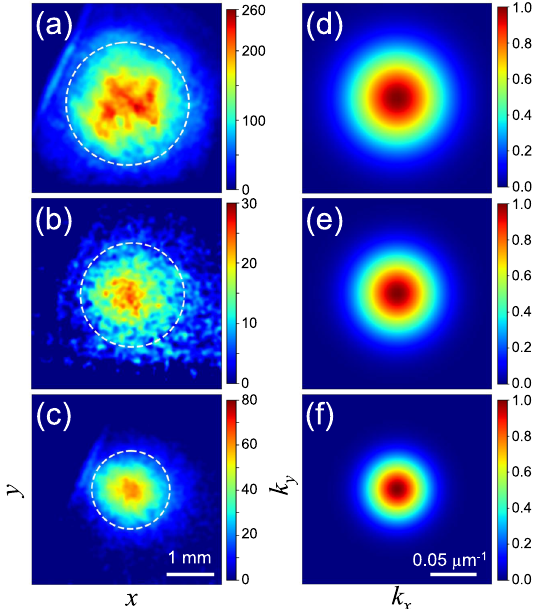
Fig. 5 Images of the output probe beam pro fi le and transverse momentum distributions of the Rydberg polaritons. a – c Images of the probe beam pro fi le taken by the electron-multiplying charge-coupled device camera (EMCCD) at Ω p = 0.2 Γ in the absence of the atoms, and at Ω p = 0.1 Γ and 0.2 Γ in the presence of the atoms, respectively. Color represents the gray level detected by the EMCCD. We fi t each image with a Gaussian function and draw a white-dashed-line circle of the diameter equal to the e − 1 full width of the best fi t. The diameters of the circles from top to bottom are 2.6, 2.2, and 1.6 mm. d – f Transverse momentum distributions of the probe photons at the output, i.e., the Rydberg polaritons in the atomic cloud, derived from the best fi ts of the images in ( a ) – ( c ), respectively. Color represents the normalized probability density. The e − 1 full widths of the distributions from top to bottom are 0.10, 0.087, and 0.065 μ m − 1 .